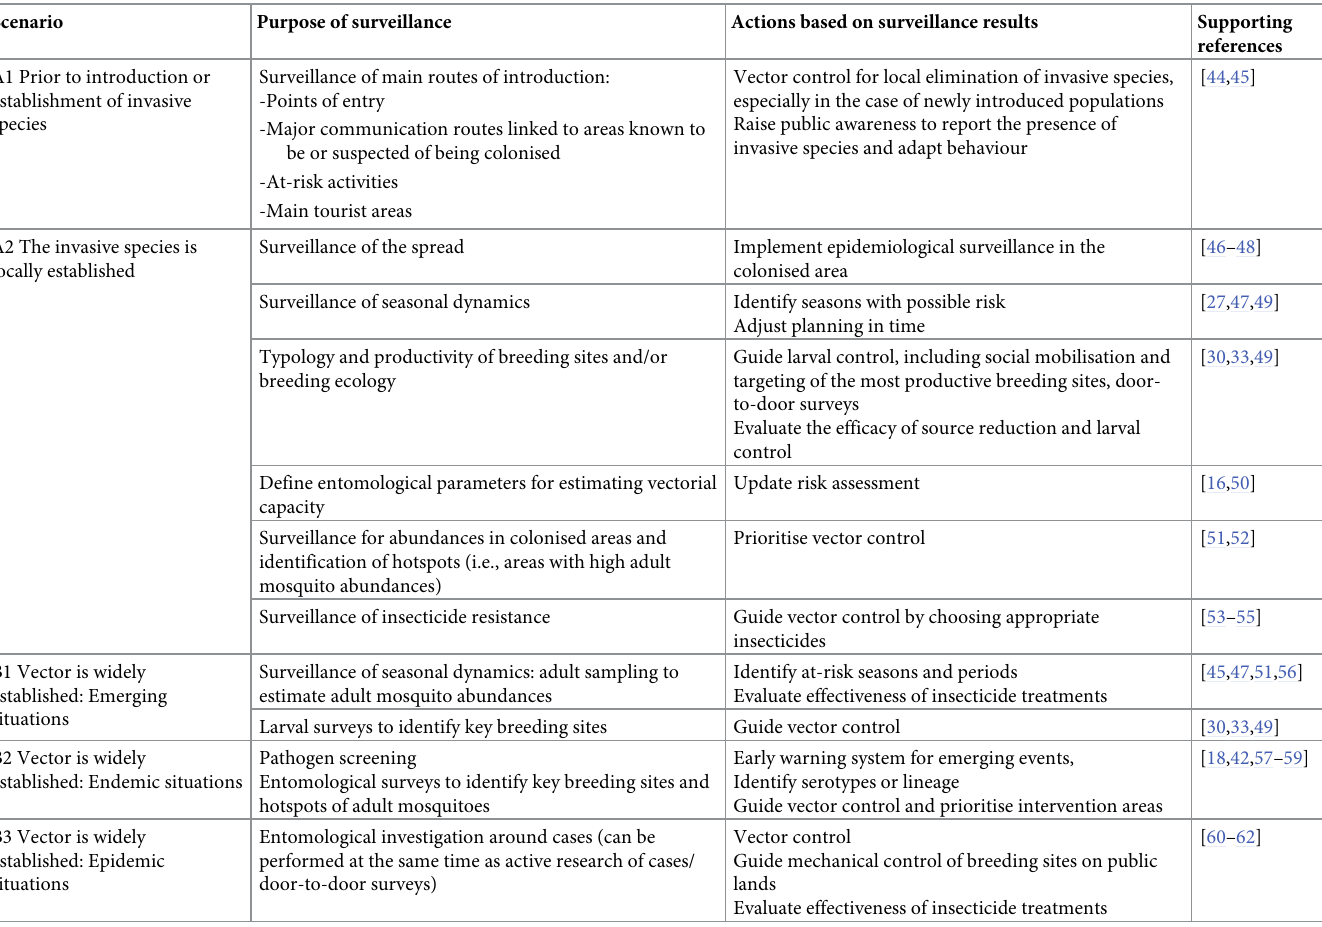
Table 2. Objectives of surveillance and possible public health actions based on entomological and epidemiological scenarios. Adapted from [10,12].